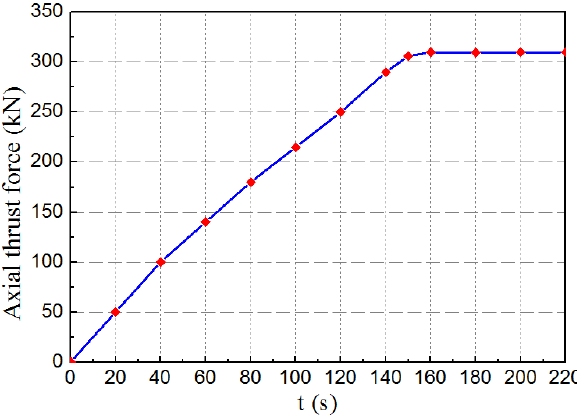
Figure 21. Loading time